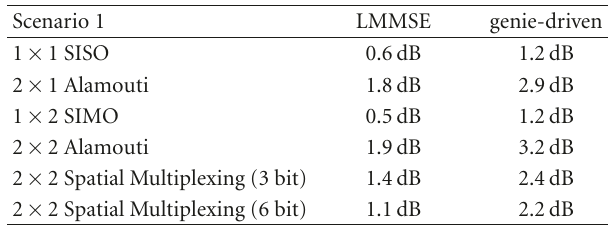
Figure 15: Simulated throughput performance for perfect and estimated channels, flat fading Rice channel with K = 2 . 9. Table 2: SNR gains of improved channel estimators over the LS